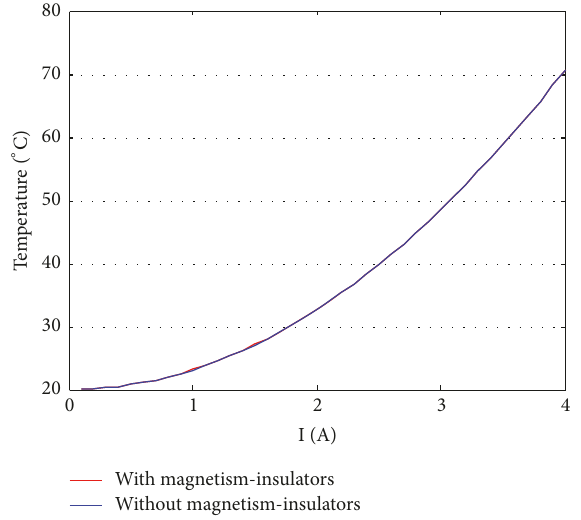
Figure 17: Maximum temperature at different currents.